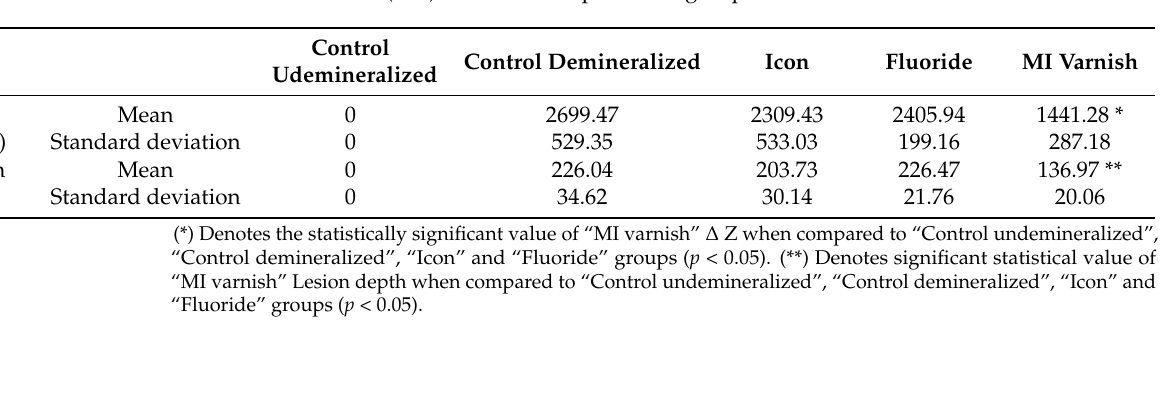
Figure 2. TMR images for all groups. Double arrows denote lesion depth. ( A ) Group 1: un-demineralized enamel group. ( B ) Group 2: control demineralized enamel group. ( C ) Group 3: MI varnish group. ( D ) Group 4: icon group. ( E ) Group 5: fluoride group. Double red arrows denote lesion depth. Table 2. Mineral loss ( ∆ Z) and Lesion depth for all